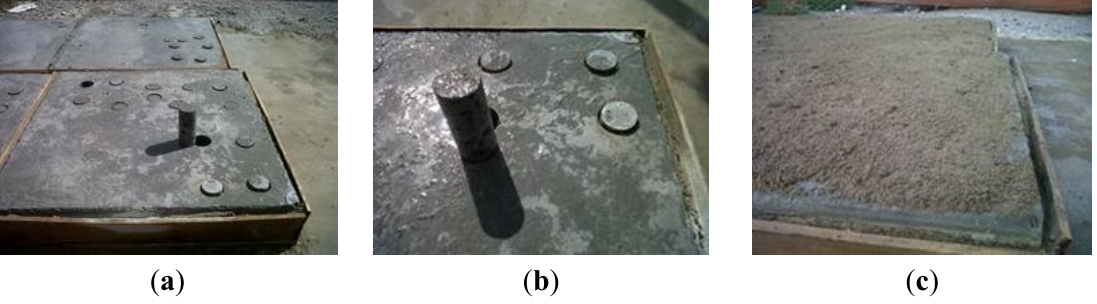
Figure 3. Cure of the specimens at local atmospheric conditions. ( a ) concrete core; ( b ) detail of concrete core; ( c ) concrete